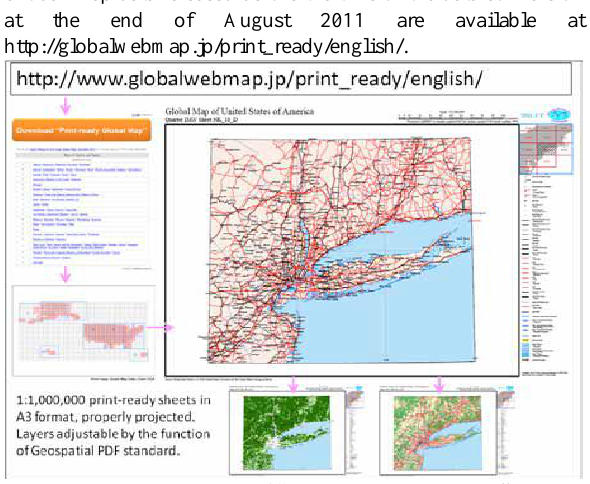
Figure 12: Release of “Print-ready Global Map”